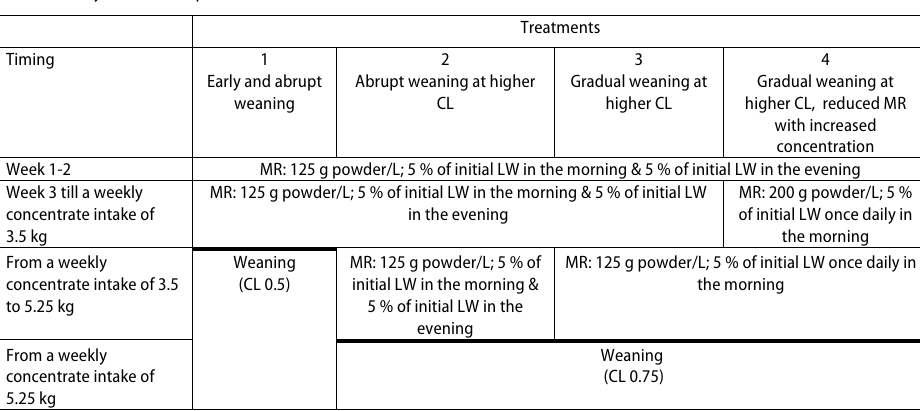
Early and abrupt weaning